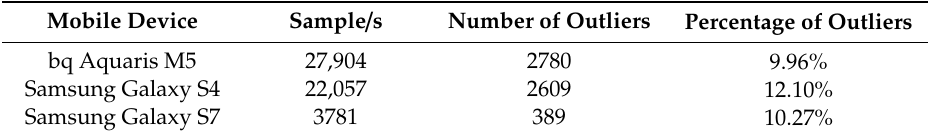
Table 2. Multivariate outliers